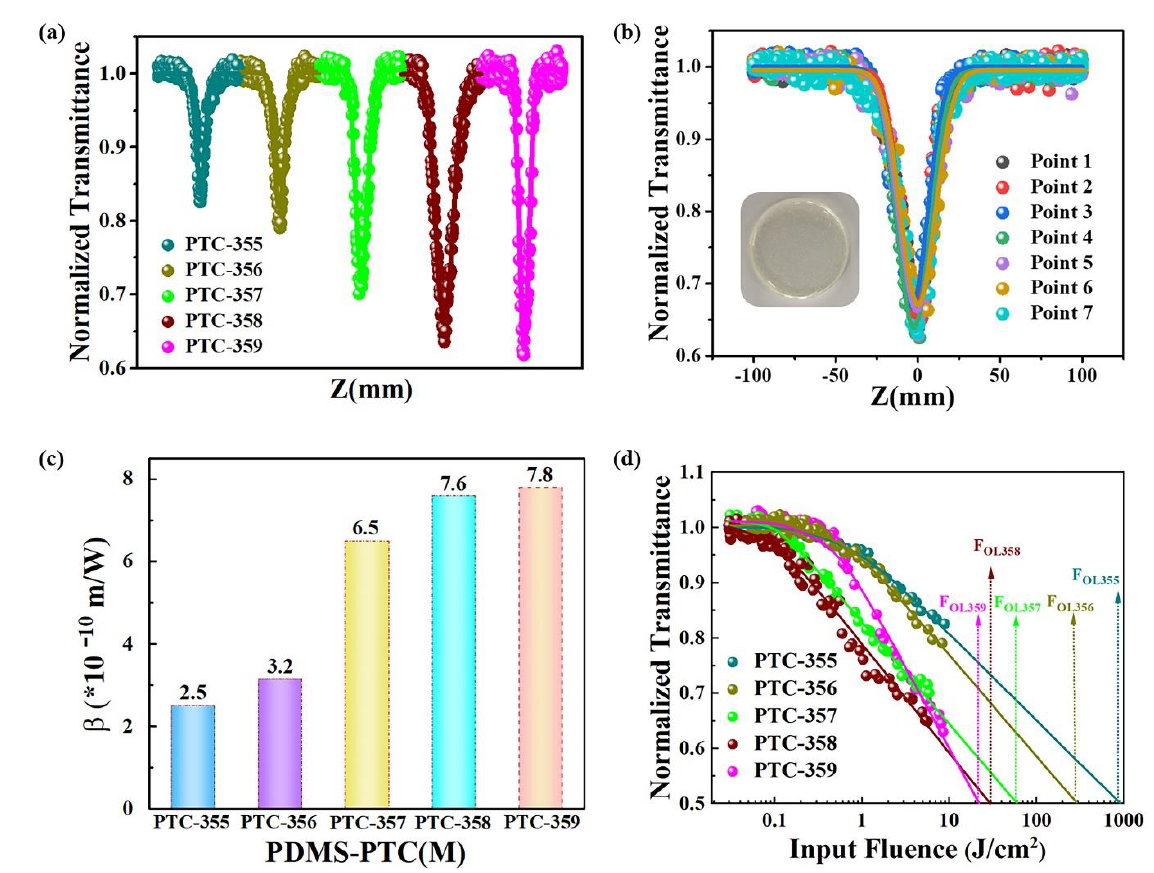
Figure 4. ( a ) OA Z-scan (points) and theoretical fit (solid lines) curves of PDMS-PTC-355 – PDMS- PTC-359 films at 532 nm. ( b ) The stability and repeatability of third-order NLO responses for the PDMS-PTC-359 film at 532 nm (inset: photo of the PDMS-PTC-359 film). ( c ) Comparison of nonlin- ear absorption coefficients ( β ) of PDMS-PTCs films. ( d ) Variation in the normalized transmittance as a function of input